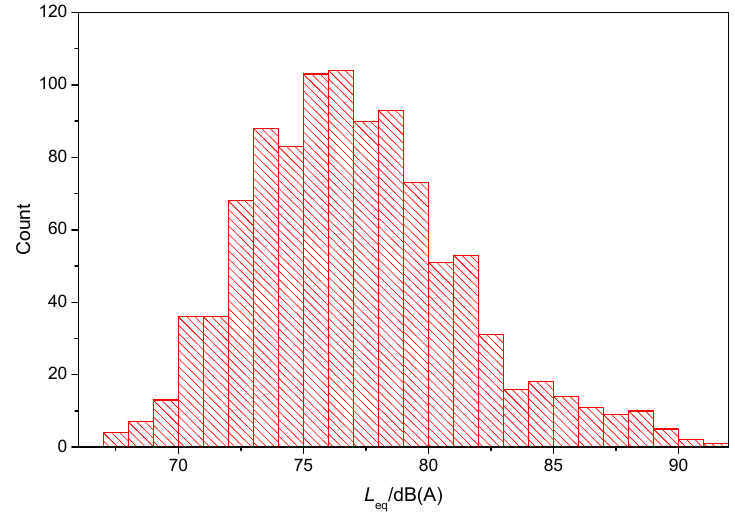
Figure 6. Statistics of equivalent SPL.